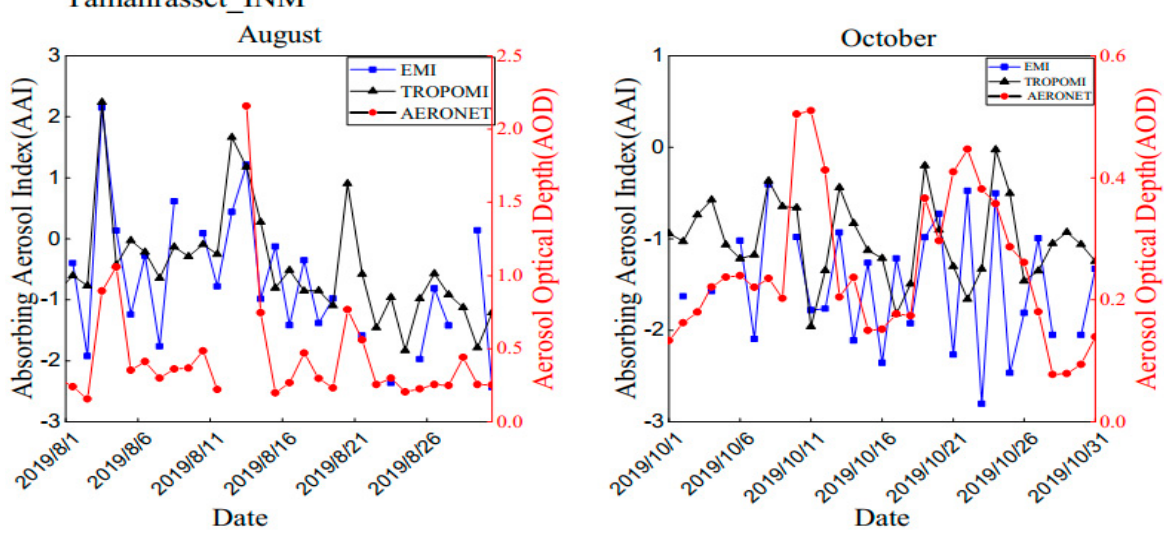
Figure 9. Variation of daily average EMI, TROPOMI AAI, and AERONET AOD for a region over the Tamanrasset_INM station for August and October 2019.